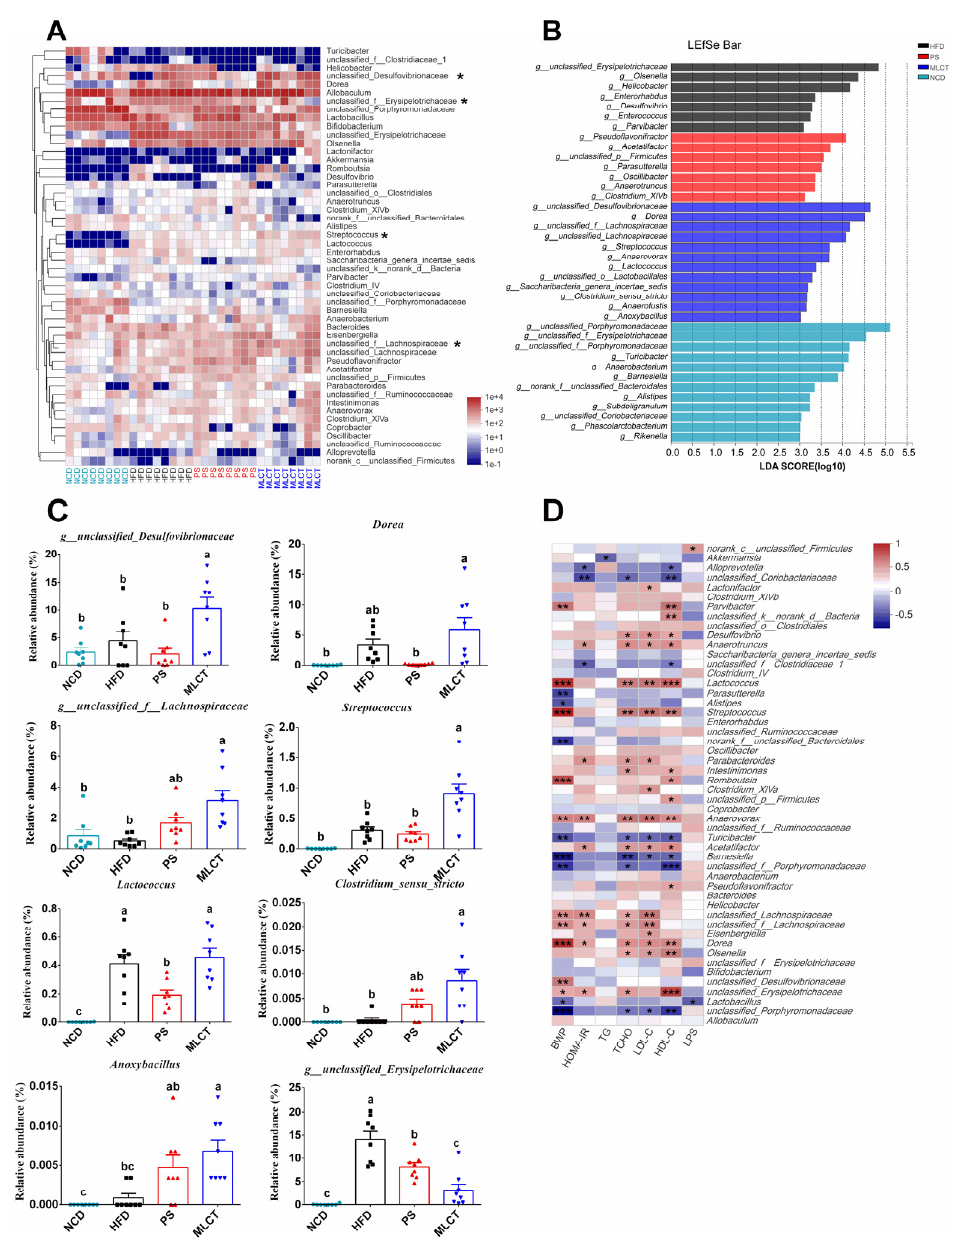
Figure 7. Effects of MLCT on the gut bacteria composition. ( A ) Heatmap analysis on genus level (the relative abundance of OTUs > 0.25%); ( B ) The LEfSe analysis (LDA > 3.0). ( C ) The relative abundance of g_unclassified _ f_Desulfovibrionaceae , Dorea , g_unclassified_f_Lachnospiraceae , Streptococcus , Lactococcus , Clostridium_sensu_stricto , Anoxybacillus , and g_unclassified_Erysipelotrichaceae . ( D ) Correlations between intestinal microflora and biochemical indicators. In ( A ), p < 0.05 marked with “*” compared with HFD group. In ( D ), p < 0.001 marked with “***”, p < 0.01 marked with “**”, p < 0.05 marked with “*”. In ( C ), means with the different lowercased letters differ significantly ( p < 0.05) according to one-way ANOVA analysis followed by Tukey’s tests.